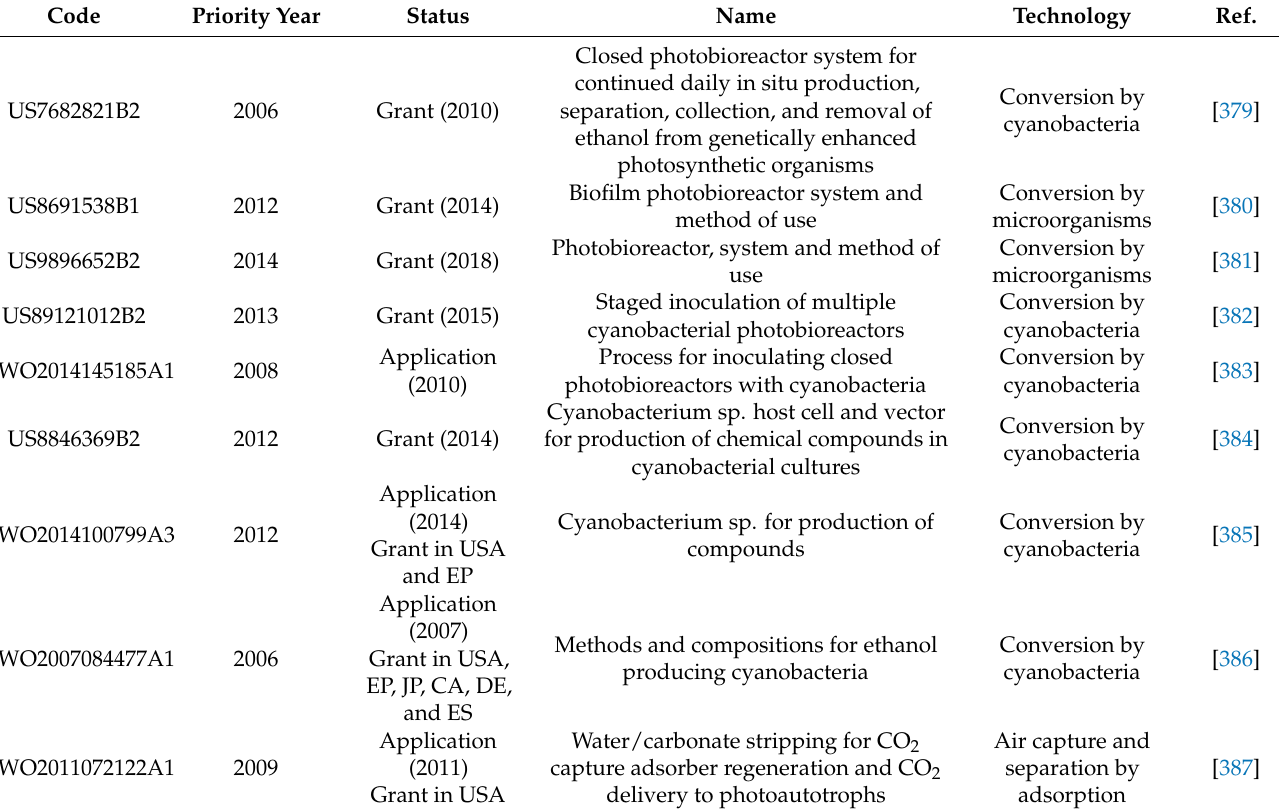
Table 15. Patents related to bioconversion and deposited by Algenol Biofuels.